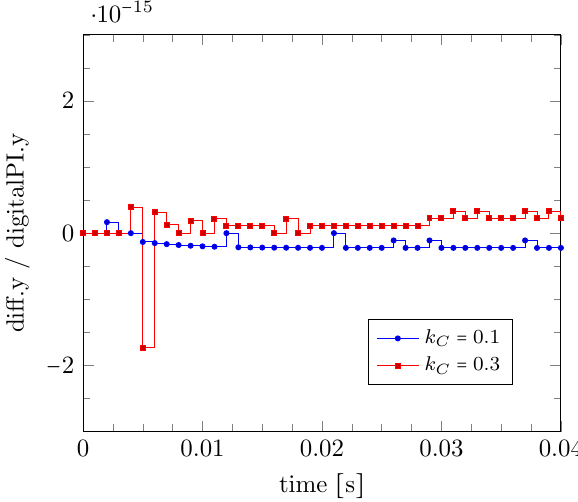
Figure 11: Relative error between the output of the “controller software” (i.e., code using the tool chain described in Section 3.7) and the “controller